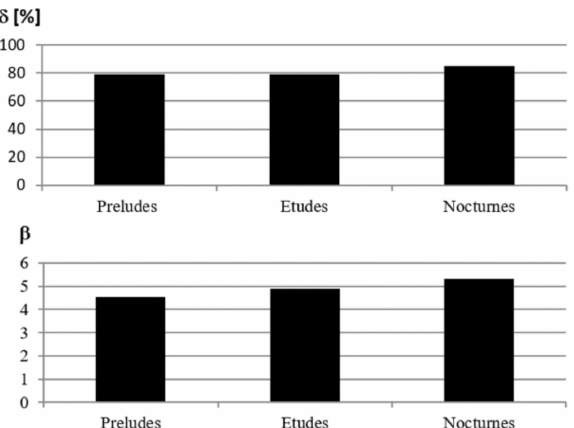
Figure 9. The efficacies of the proposed method obtained individually for particular collections by F.